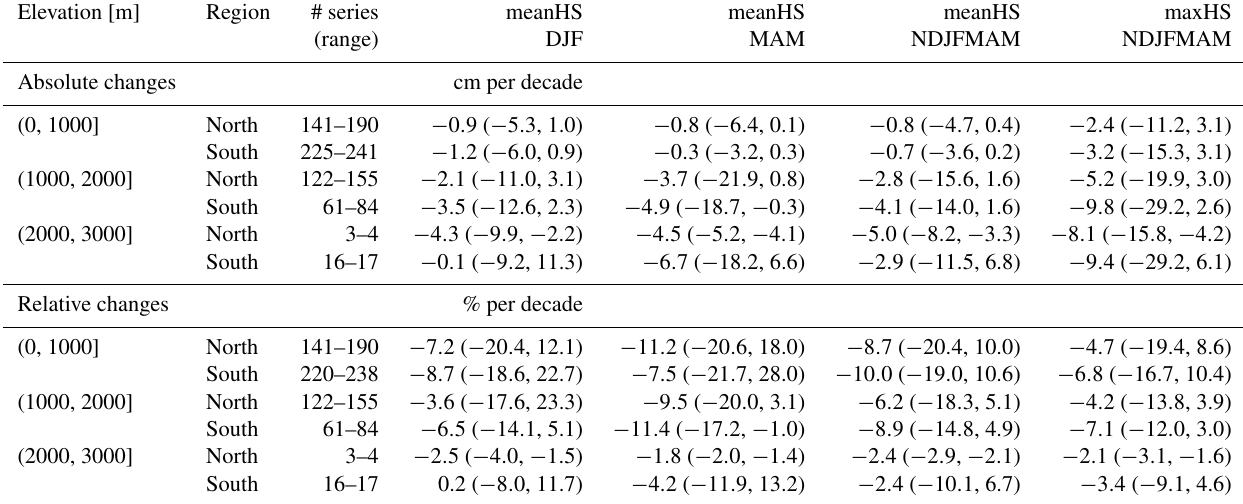
Table 3. Summary of 1971 to 2019 trends in seasonal snow indices. The five regions were collapsed into two (north and south). The number of stations differs by season, and the range of available series is indicated in the third column. Average trends (with minimum and maximum in parentheses) are given for seasonal indices of mean snow depth (meanHS) and maximum snow depth (maxHS). The season is indicated in the second row with the first letter of the included months (e.g. DJF is December, January, and February). Absolute trends are in centimetres per decade for meanHS and maxHS. Relative trends are expressed as percent per decade (% per decade). A few stations in the south below 1000m were removed because their low and insignificant snow amounts caused unlikely high relative